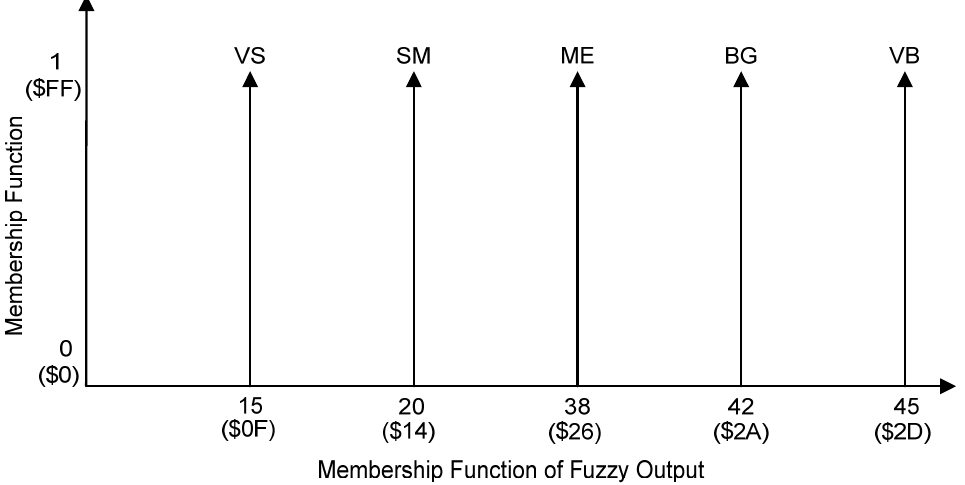
Figure 6. MF of fuzzy output (reference angle = 70 ◦ ) with digital scaling format. The singleton output